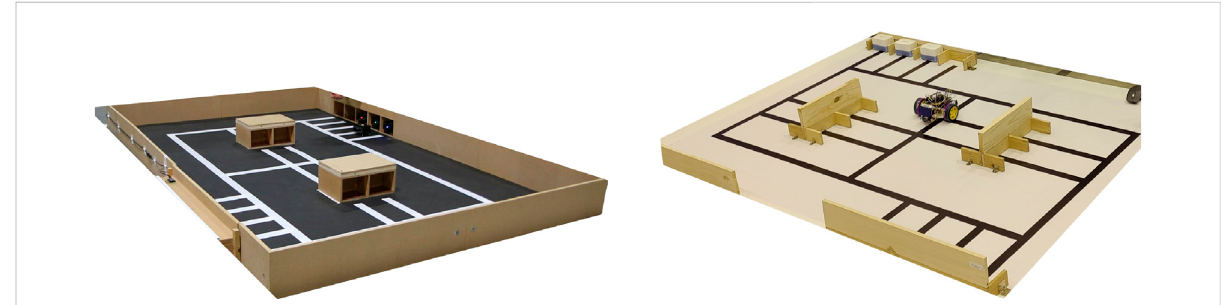
FIGURE 1 RobotAtFactory original fi eld (left). RobotAtFactory Lite fi eld